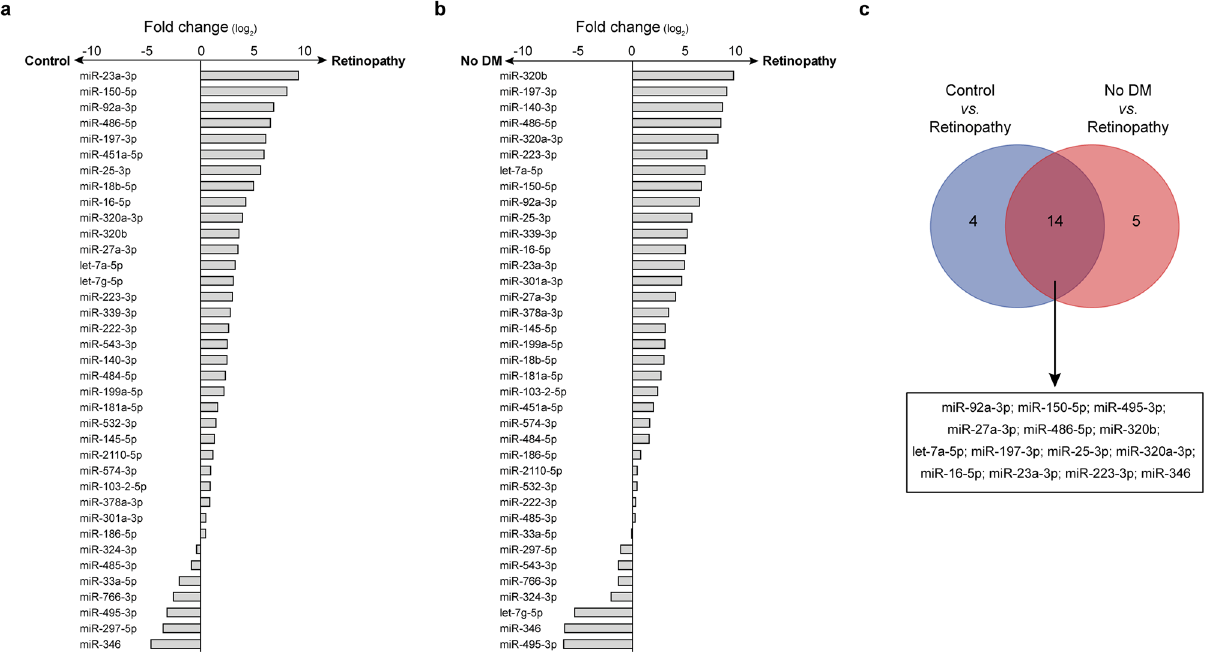
Figure 1. Circulating miRNome screening of DR. ( a , b ) Analysis of circulating miRNAs in pooled samples of diabetic patients with DR (Retinopathy) vs. diabetic patients without DR (Control) ( a ) or individuals without diabetes and retinopathy (No DM) ( b ). The x-axis indicates the fold changes on a log 2 scale. DM, diabetes mellitus. ( c ) Venn’s diagram depicts the proportion of miRNAs consistently dysregulated in analyses in ( a ) and ( b ). The list of miRNAs is reported